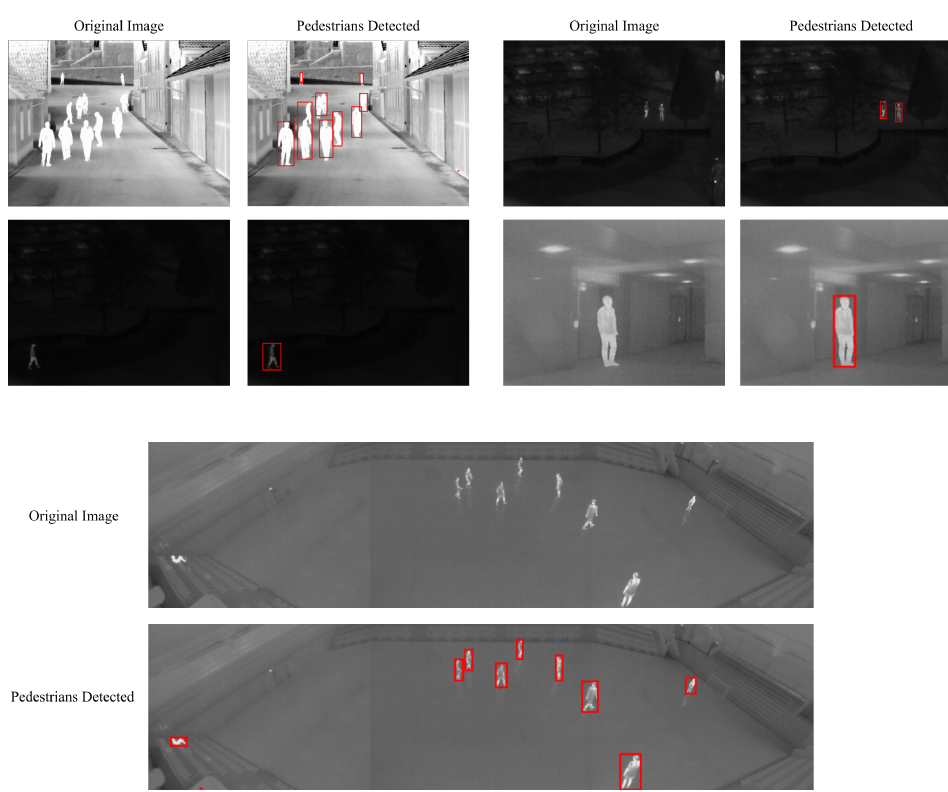
Figure 9. Detected pedestrians on images from the LTIR dataset after validation.